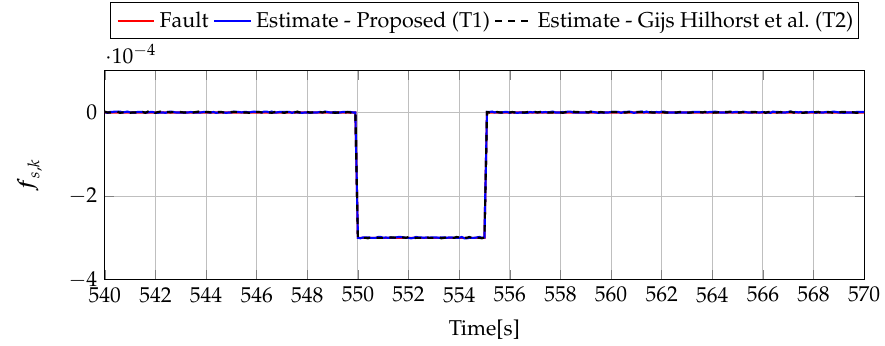
Figure 20. Fault f (red line) and fault estimate obtained with Theorem 1 (T1) and Theorem 2 (T2) s , k based on [39] for FS3 (for t = 540, . . . ,570 [s]) as well as the response for disturbance signal w 1, k